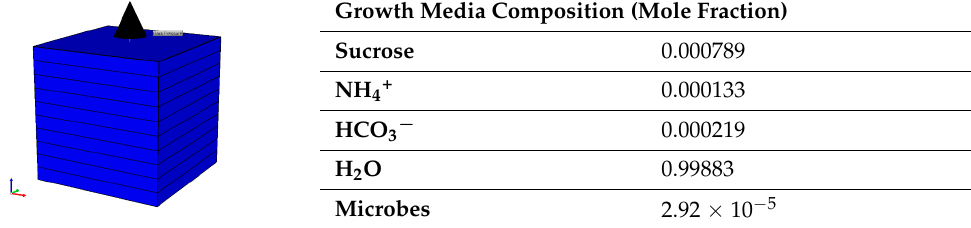
Table A2. Sandpack model for permeability reduction [54]. Model